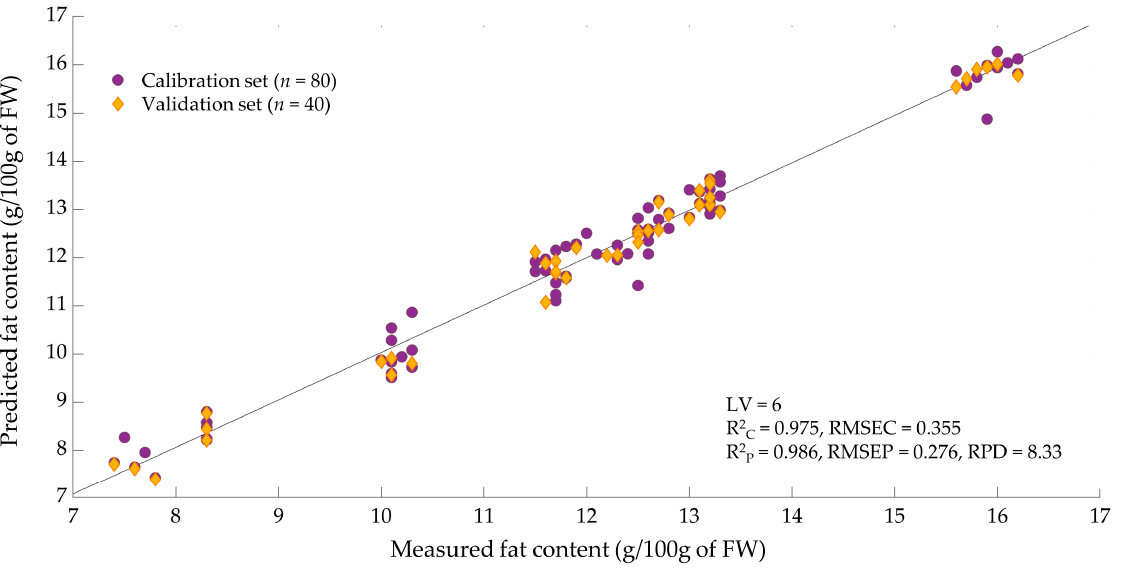
Figure 4. Comparison of the measured and predicted values of the fat content of living Tenebrio molitor larvae in the calibration and validation sets.